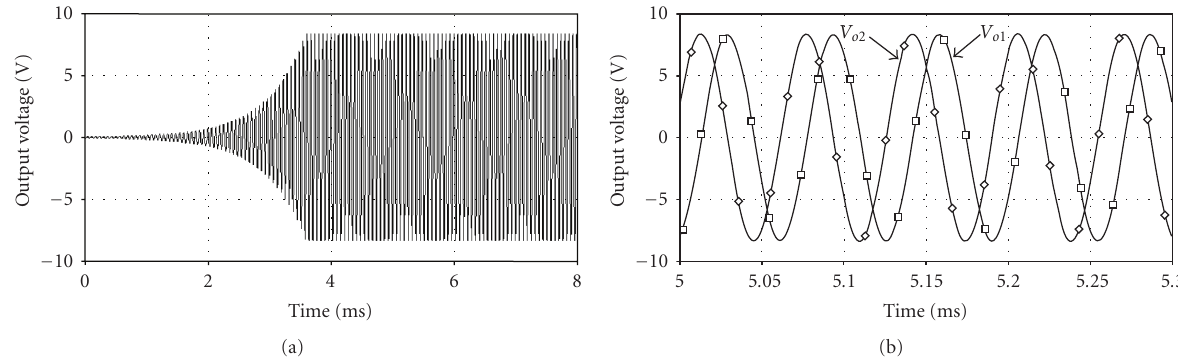
Figure 8: Simulated output waveforms V o 1 and V o 2 of the proposed oscillator of Figure 4, (a) at transient stage and (b) at steady stage.